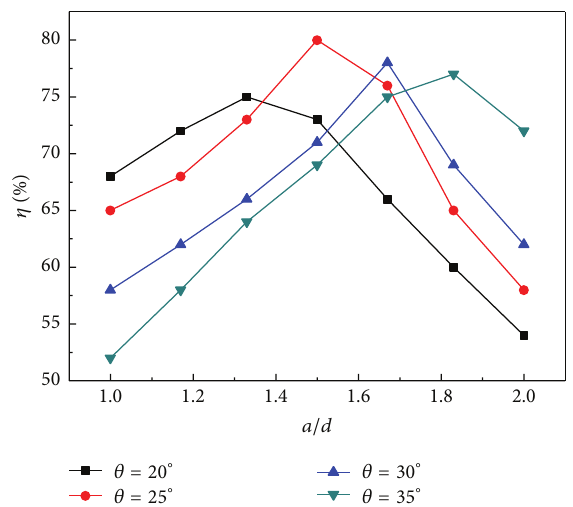
Figure 4: Effect of mesh aperture size on the sieving